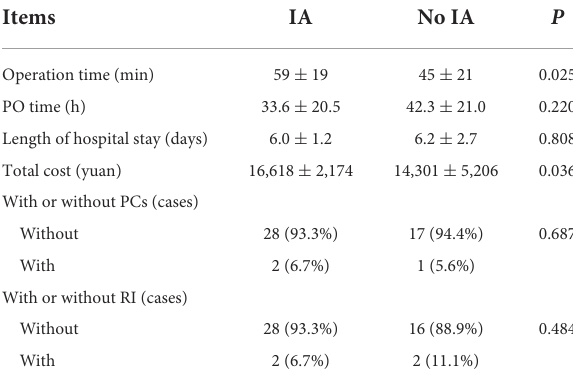
TABLE 1 Characteristics of patients. TABLE 2 The comparison between patients with and without